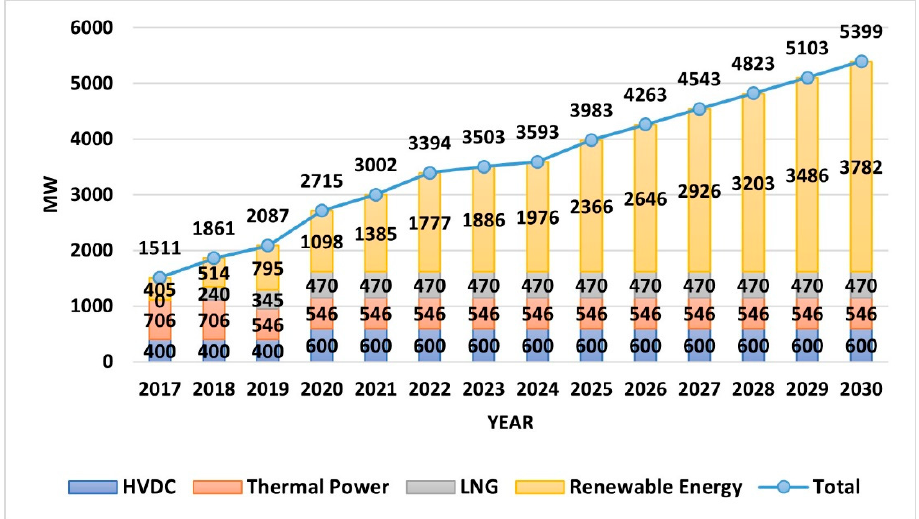
Figure 5. Projected installed capacity for Jeju until 2030.